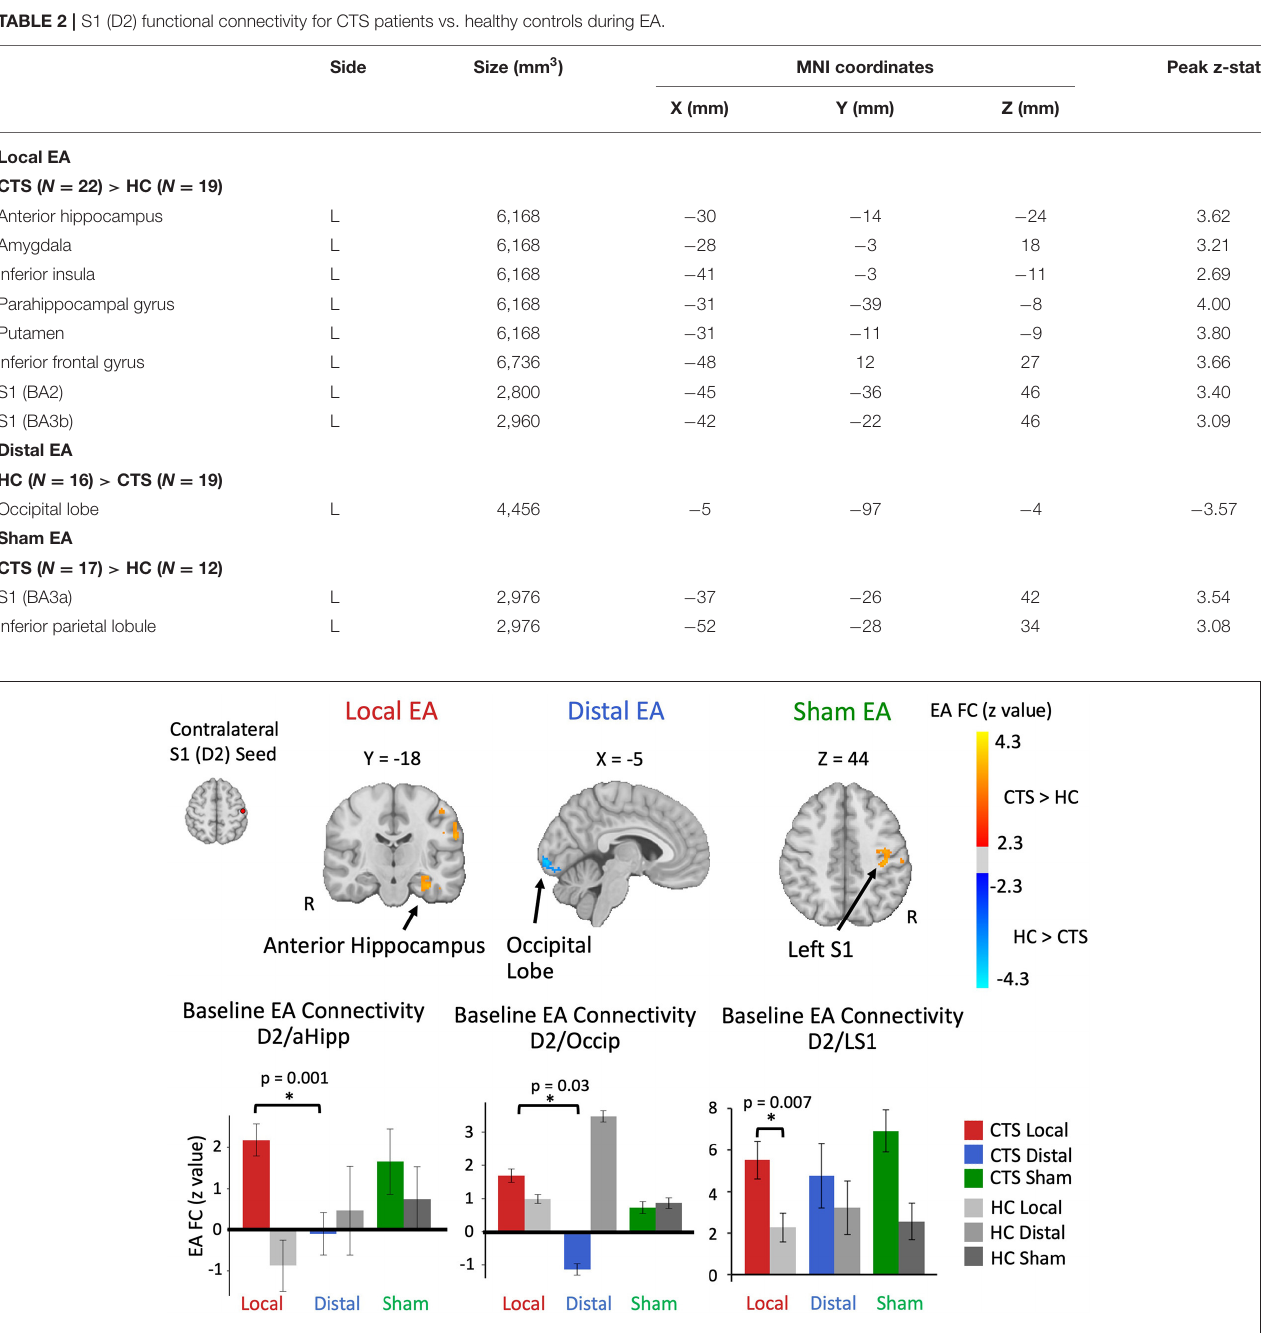
FIGURE 2 | Altered baseline S1 (D2) functional connectivity during sustained electro-acupuncture (EA) in CTS patients. Compared to healthy controls, D2 contralateral to most affected hand in CTS patients was more functionally connected to anterior hippocampus during local EA, less connected to the occipital lobe during distal EA, and more connected to left S1 during sham. Both D2 to anterior hippocampus and D2 to occipital functional connectivity were elevated during local and distal EA for CTS patients in ROI-to-ROI analyses. D2 to left S1 functional connectivity during sustained local EA was elevated for CTS patients compared to healthy controls. HC, healthy controls; S1, primary somatosensory cortex; D2, S1 cortical representation of the second digit of the hand; Occip, occipital cortex; FC, functional connectivity.